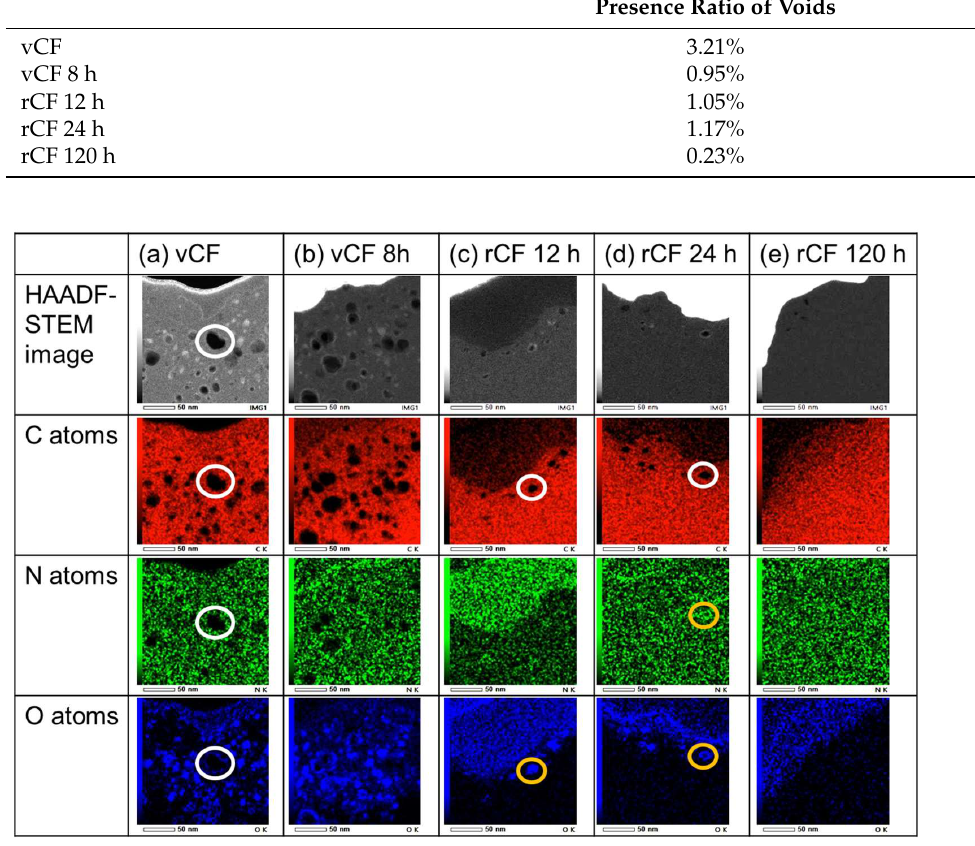
Figure 8. Results of EDX mapping to cross-section for ( a ) vCF, ( b ) vCF 8 h, and rCF ( c ) 12 h, ( d ) 24 h, and ( e ) 120 h, where the white circle represents the presence of the voids and orange circle represents the N or O atoms existing inside the voids. Table 2. Presence ratio of voids existing inside vCF and rCF.